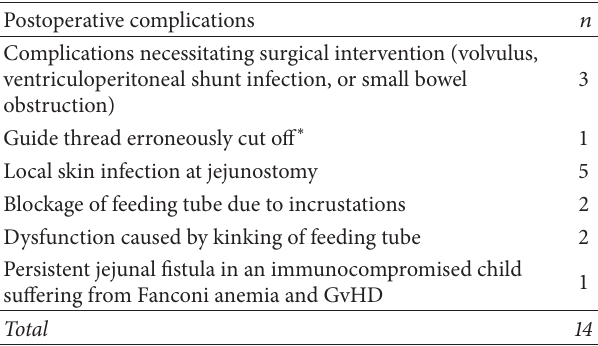
Table 1: Complications after RJFT placement.